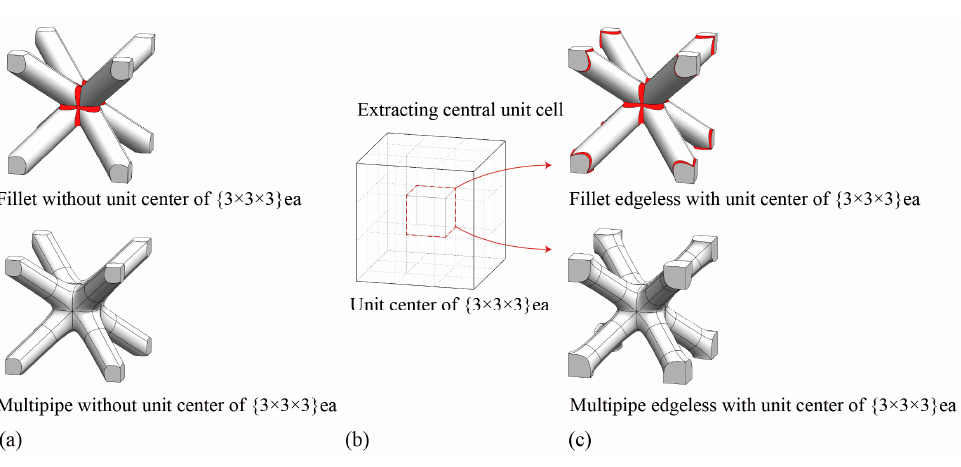
Figure 5. Concept of the unit center of {3 × 3 × 3} ea process: ( a ) fi llet and multipipe edgeless functions applied to a unit cell; ( b ) the unit center of {3 × 3 × 3} ea process; ( c ) fi llet and multipipe edgeless unit cells created using the unit center of {3 × 3 × 3} ea process. Red-colored areas indicate where the edgeless functions were implemented.